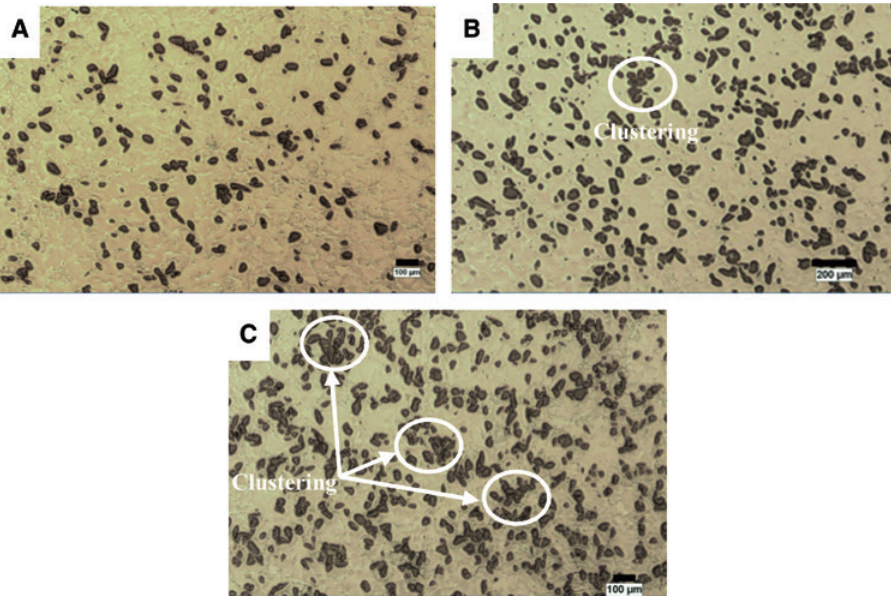
C, (B) 10% B C and (C) 15% B 4 4